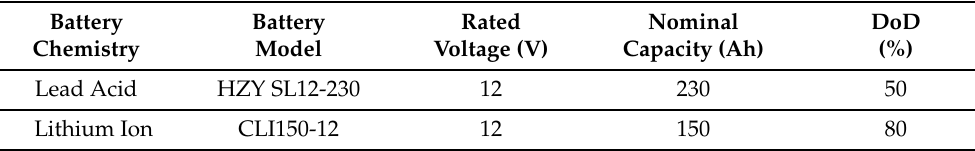
Table 2. Main data for the batteries considered in this